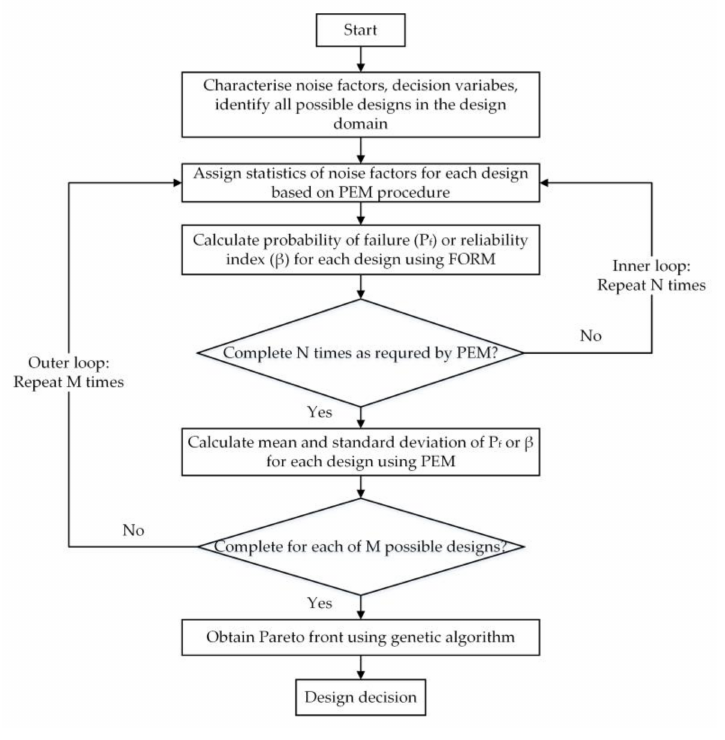
Figure 1. The flowchart of the RGD